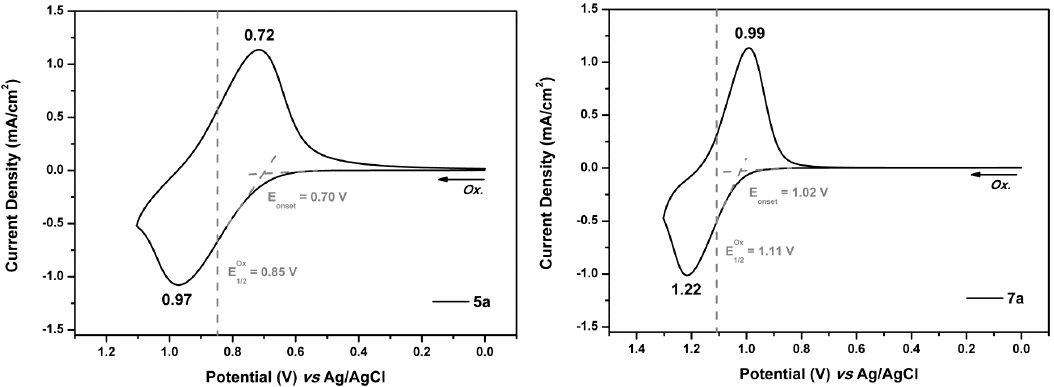
Figure 8. Cyclic voltammogram of the polyamide (PA) 5a and polyimide (PI) 7a films on the ITO-coated glass slide in 0.1 M TBAP/MeCN with a scan rate of 50 mV s − 1 .